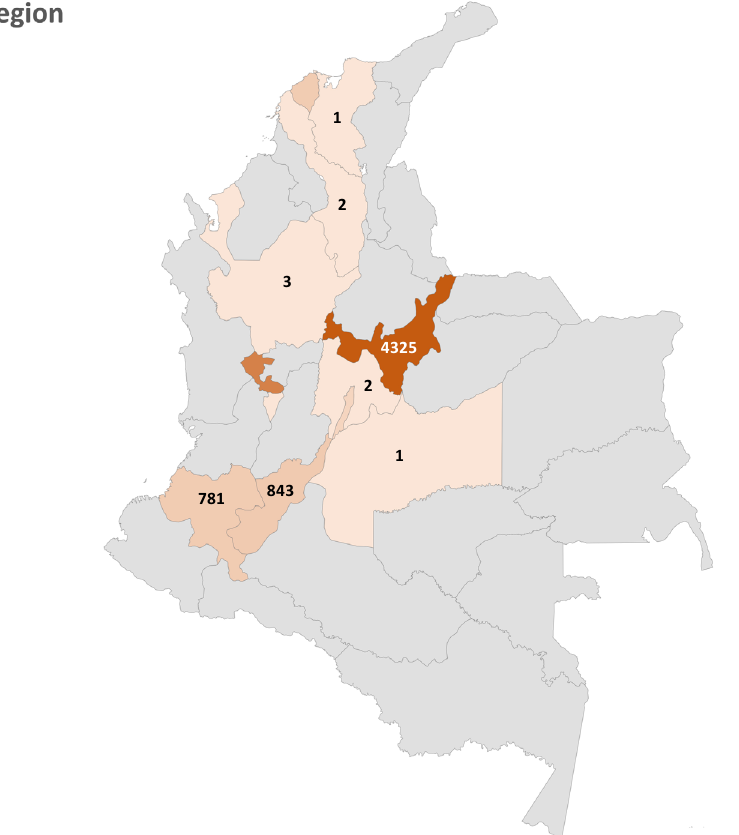
Figure 1. Distribution of samples taken by